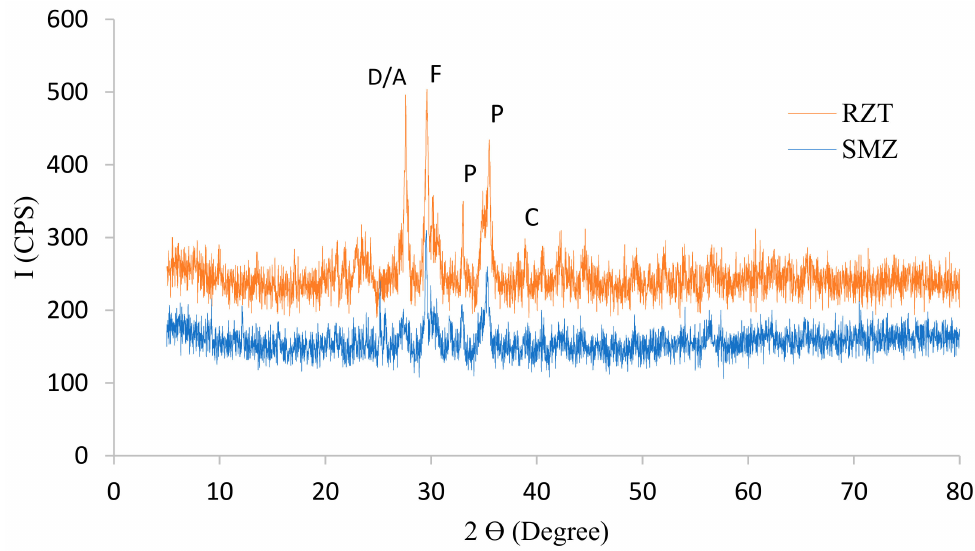
Figure 2. XRD patterns for RZT and SMZ where P—phillipsite, F—Faujasite; A—anorthite, D—diopside;